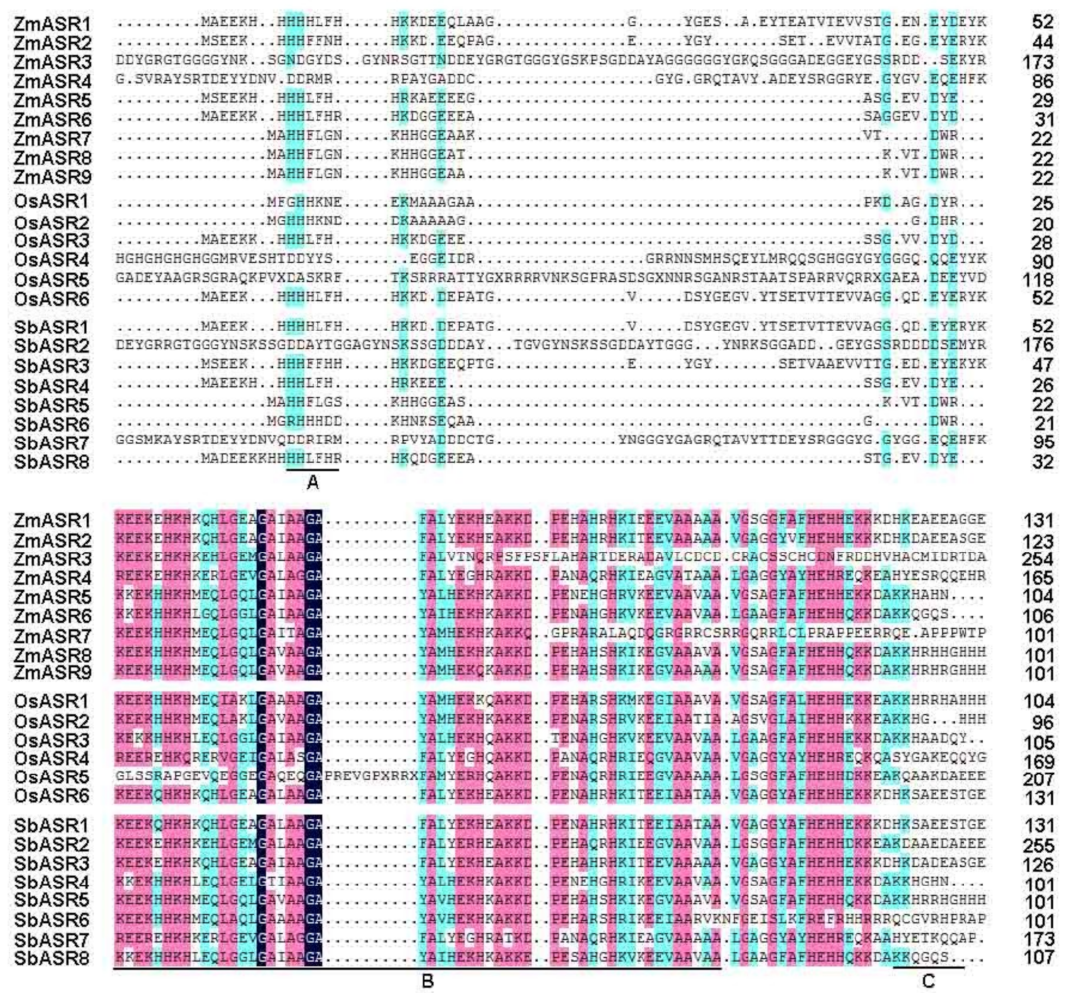
Figure 1. Alignment of amino acid sequences of abscisic acid (ABA)-, stress-, and ripening-induced (ASR) proteins. ( A ) The zinc-binding region; ( B ) the ABA / water deficit stress (WDS) domain; and ( C ) the putative nuclear targeting signal. The shading of the alignment presents identical residues in magenta, blue and dark blue colors, and the high conserved amino are marked at the